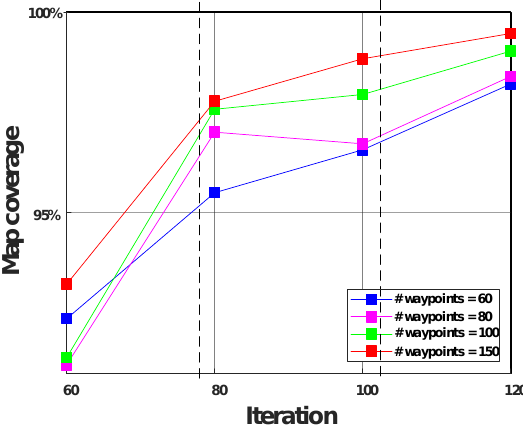
Figure 8. Pareto optimal set of the results of the MOGWO exploration algorithm.